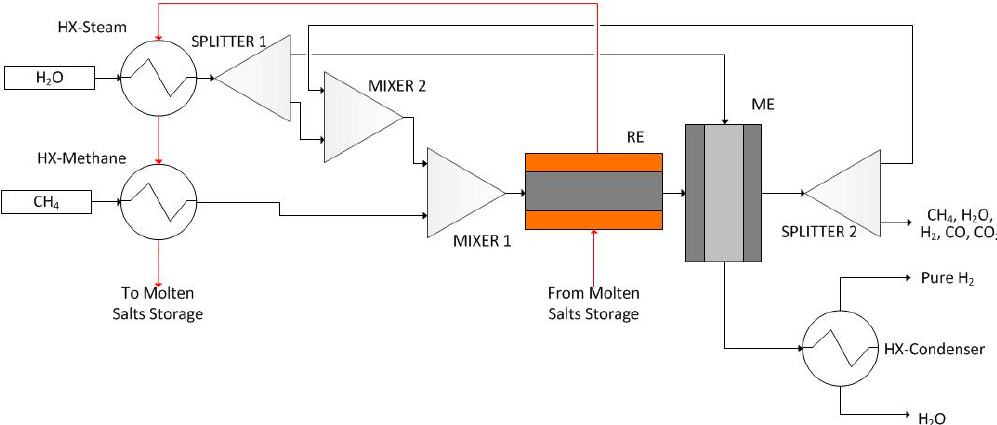
Figure 3. Cascaded reactor-membrane flowsheet configuration (CRM). Membranes 2019 , 9 , x FOR PEER REVIEW